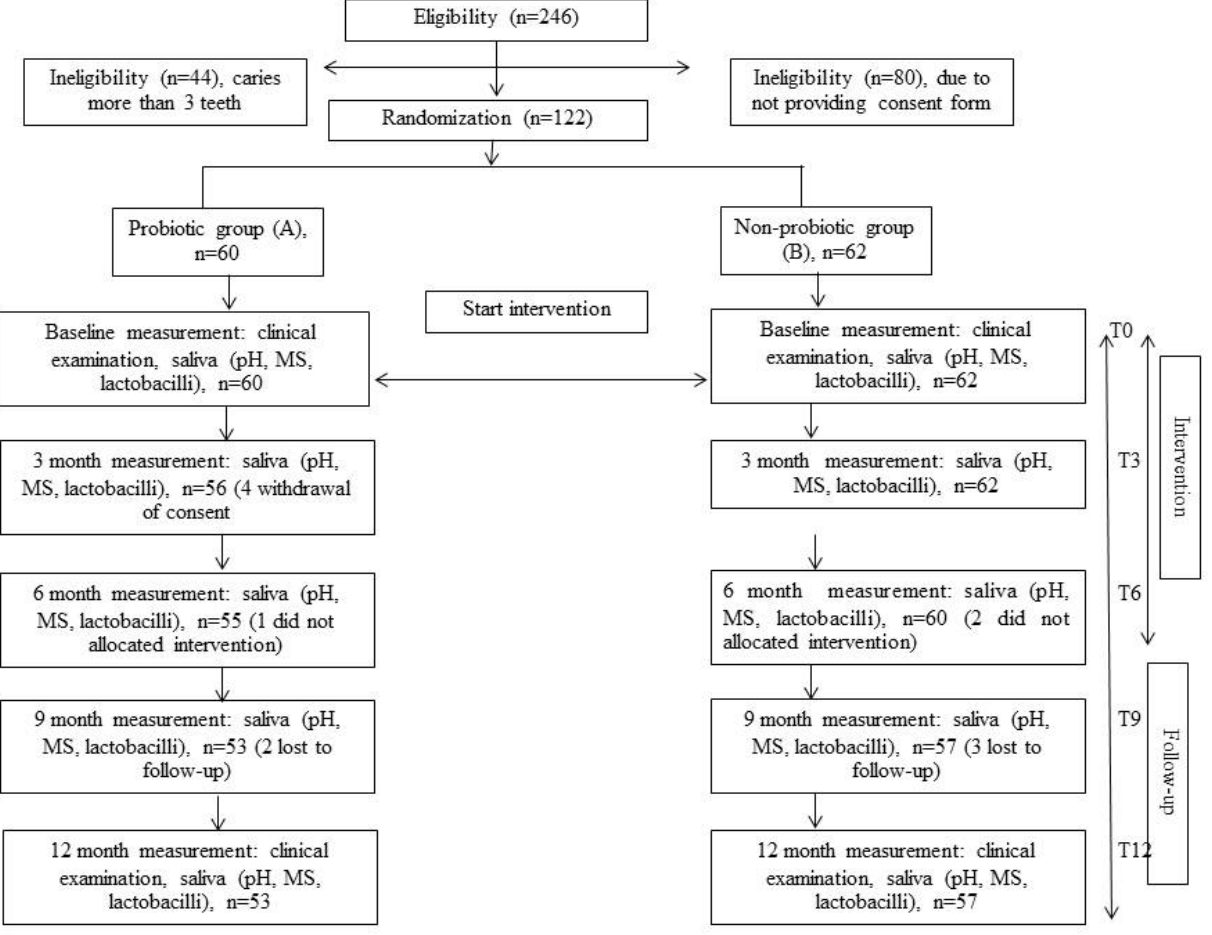
Figure 1. Flow-chart showing the progress of children participating at each time period of the 12-month